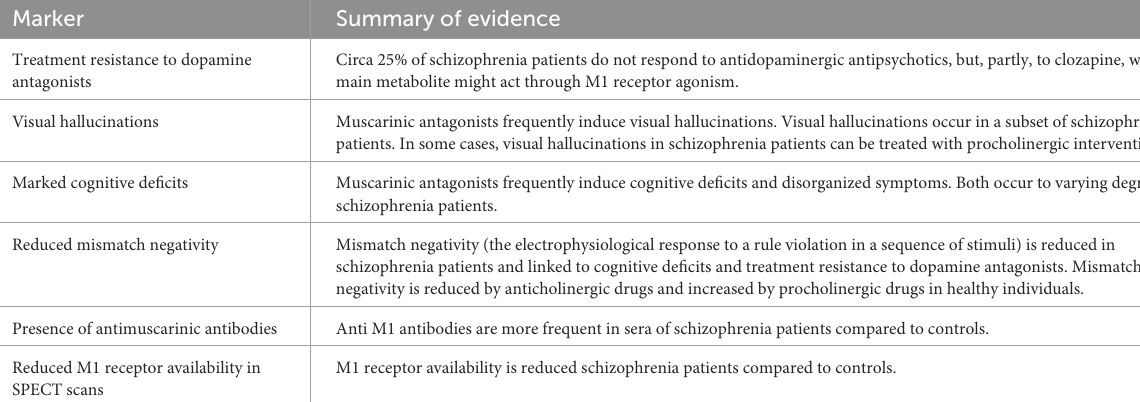
TABLE 2 Possible markers of muscarinic deficits in schizophrenia and brief summary of the